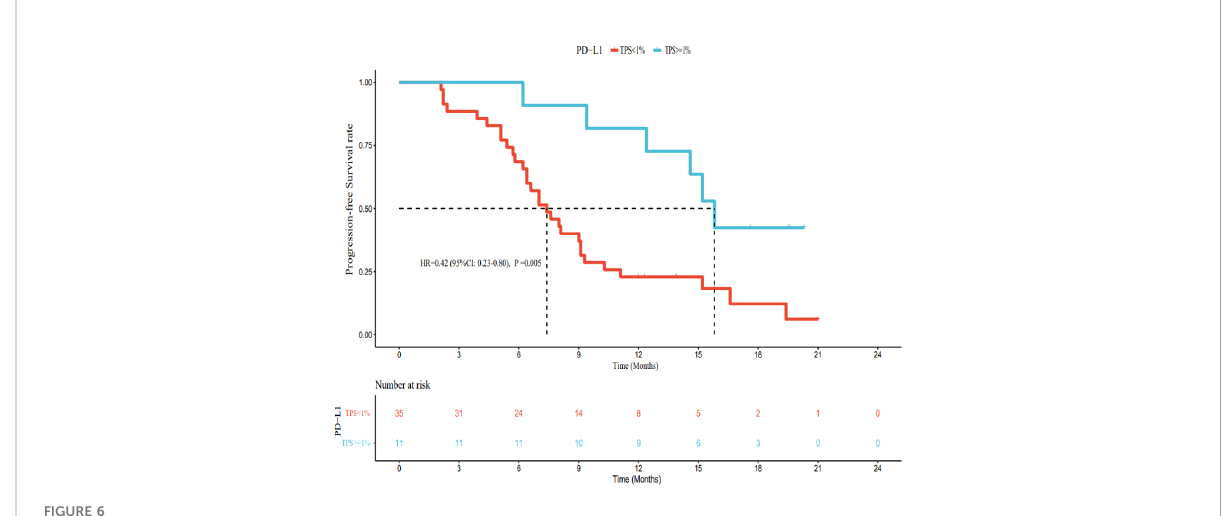
FIGURE 6 The relationship between PD-L1 expression and progression-free survival.